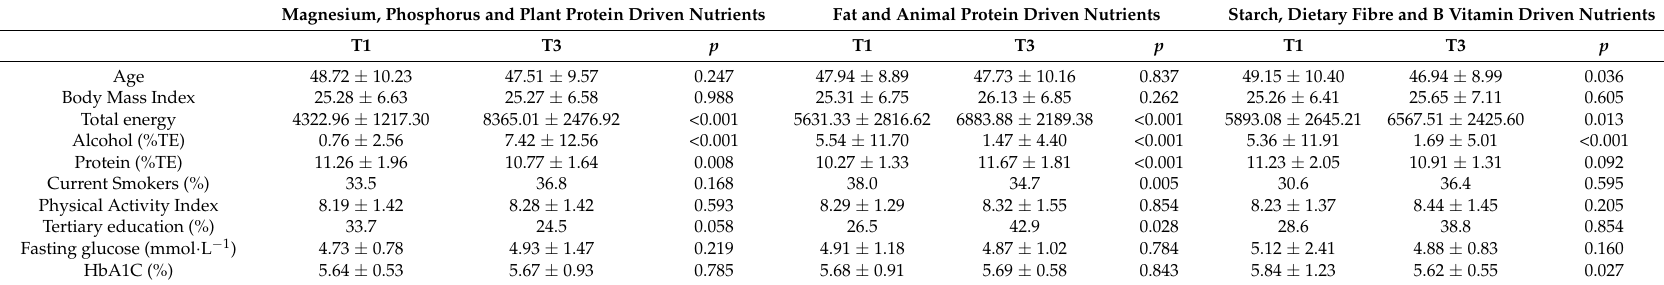
Table 1. Descriptive characteristics for the rural women of the study population according to the lowest and highest tertiles of the three nutrient patterns (PC). Magnesium, Phosphorus and Plant Protein Driven Nutrients Fat and Animal Protein Driven Nutrients Starch, Dietary Fibre and B Vitamin Driven Nutrients T1 T3 p T1 T3 p T1 T3 p